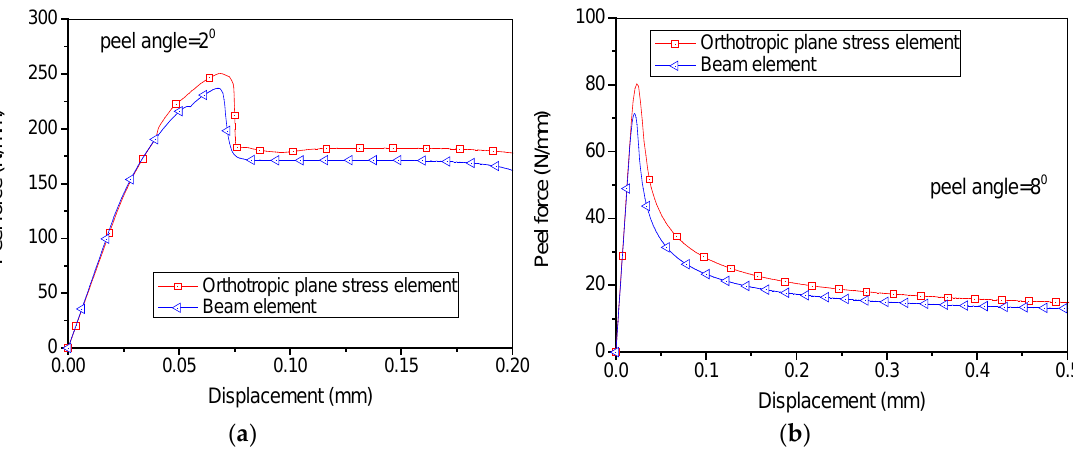
Figure 7. Influence of different element types on the load-displacement curves (2 layers of dry fiber sheets): ( a ) Peel angle = 2 degree; ( b ) Peel angle = 8 degree.